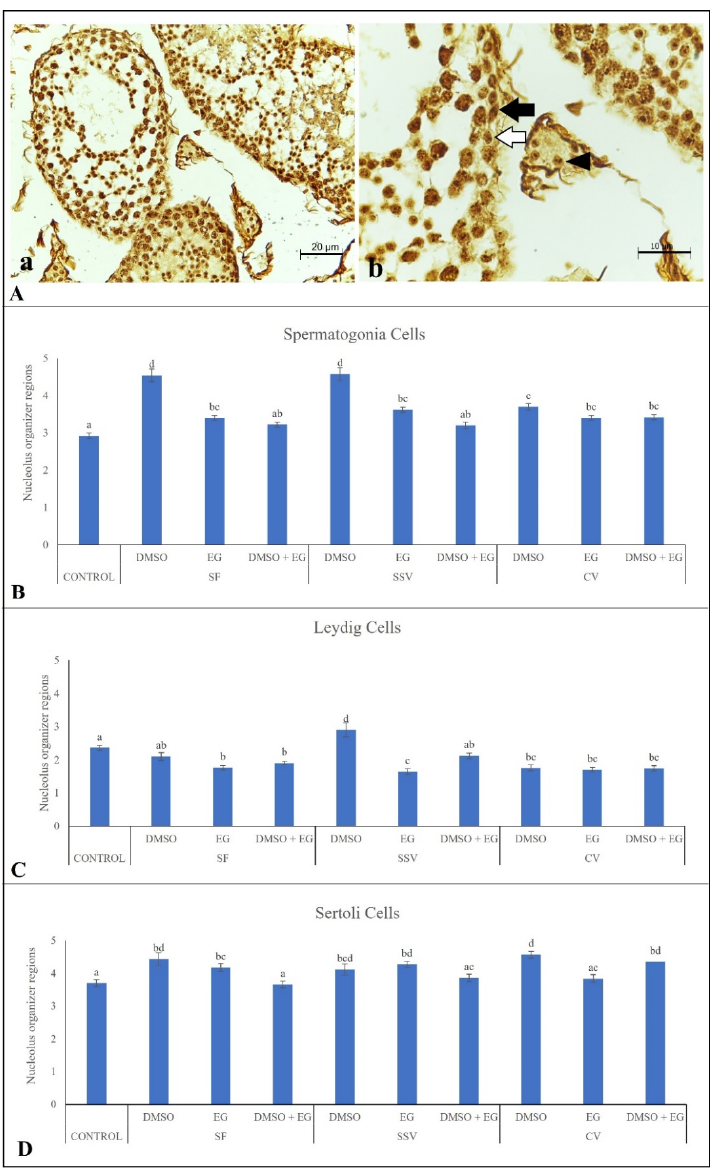
Figure 4. ( A ) Representative picture of proliferative potential evaluated by the quantification of nucleolar organizer regions (NORs) in testicular cells from adult red-rumped agoutis (n = 5 males): ( a ) Seminiferous tubule, scale bar: 20 µm; ( b ) enlarged seminiferous tubule area showing spermatogo- nia (white arrow), Leydig cell (black arrowhead), and Sertoli cell (black arrow), scale bar: 10 µm. ( B – D ) evaluations of proliferative capacity as the average number NORs (mean ± SEM) in spermat- ogonia ( B ), Leydig cells ( C ), and Sertoli cells ( D ) exposed to different treatments (slow freezing, SF; solid-surface vitrification, SSV; and conventional vitrification, CV) with different cryoprotectants (dimethyl sulfoxide, DMSO; ethylene glycol, EG; DMSO + EG combination). a–d Different lowercase letters above bars indicate differences among treatments ( p < 0.05).